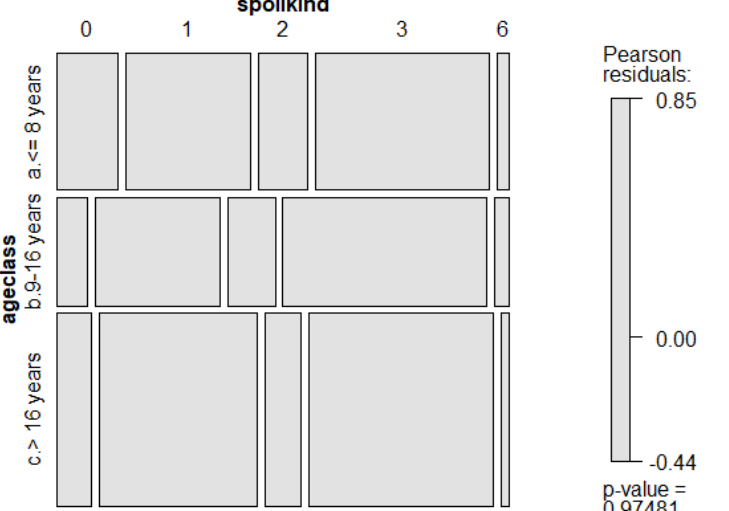
Figure 7. Mosaic graph showing the frequency of different kinds of spoilage in the three classes of bunker age.